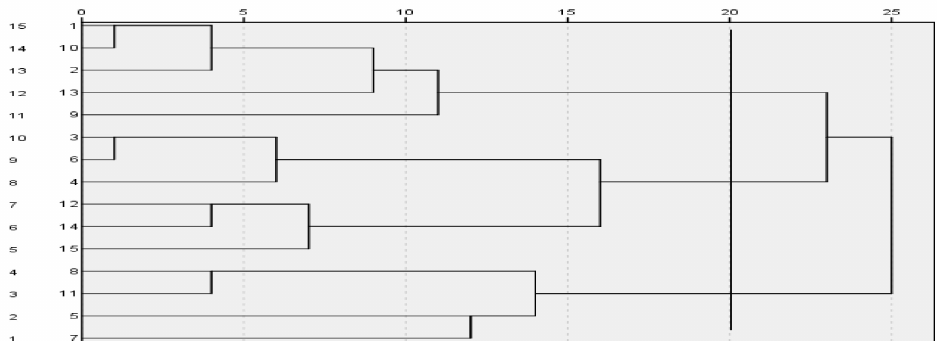
Figure 5. Clustering diagram of three groups of representative Kansei words. is the 3-cluster training sample cut-off.